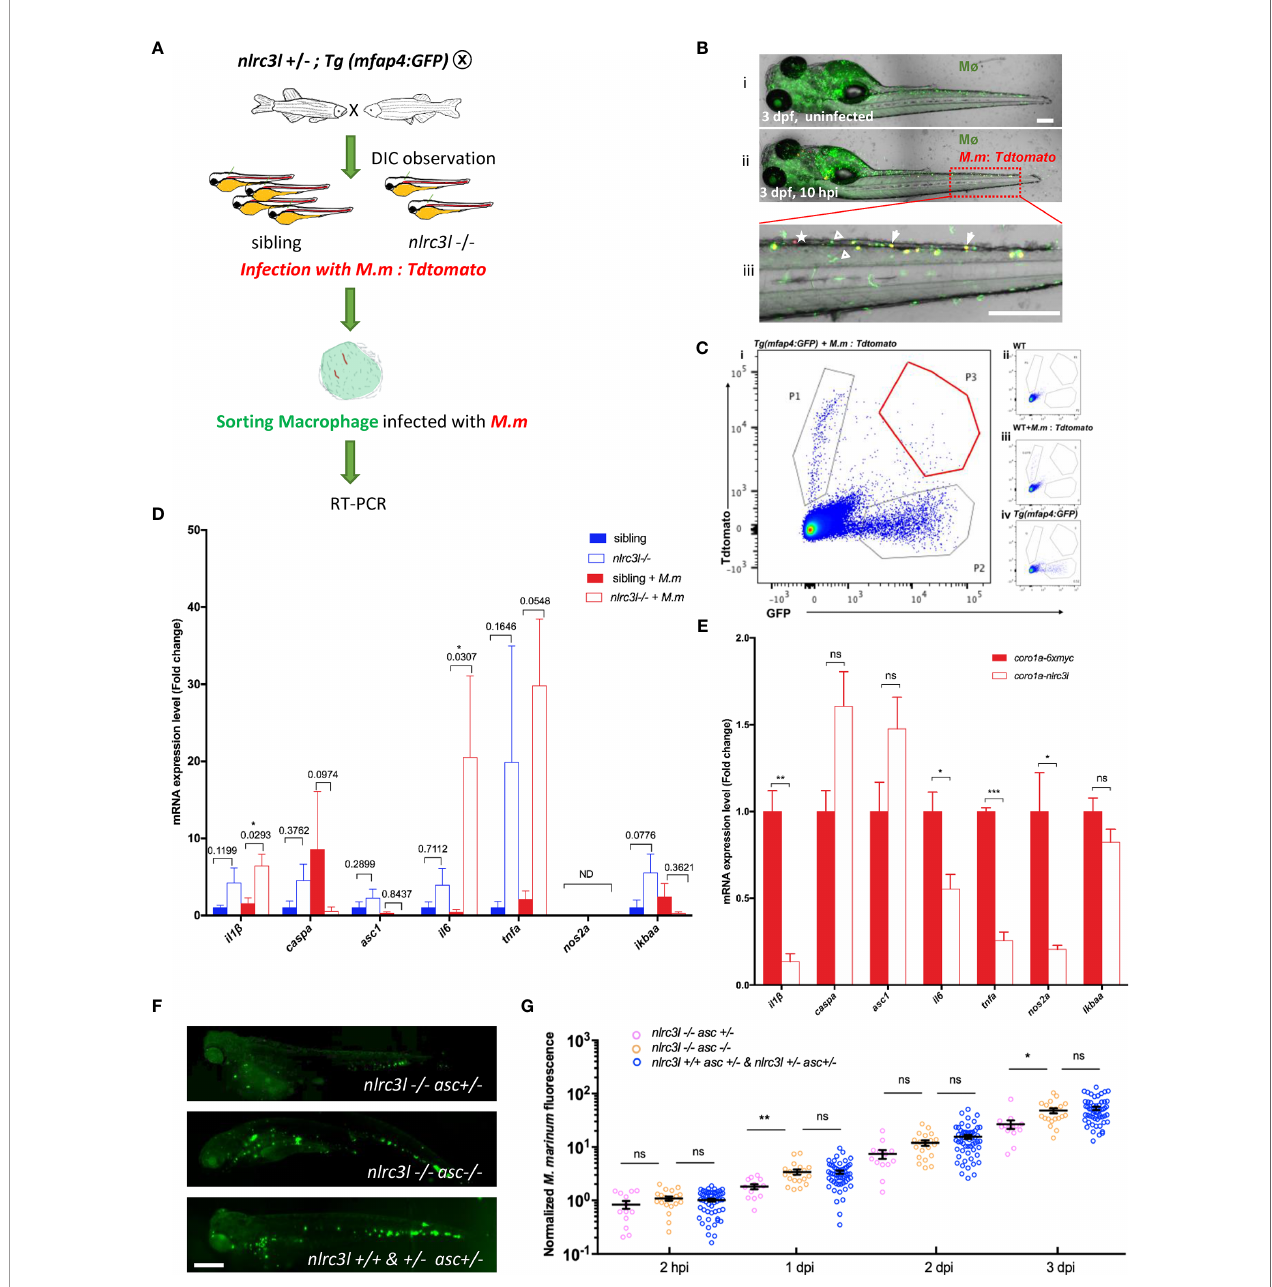
FIGURE 4 | nlrc3-like de fi ciency promotes the activation of macrophage in fl ammasome. (A) Schematic view of FACS of mfap4-GFP + macrophages with phagocytosed Tdtomato + M. marinum and subsequent detection of the expression of in fl ammation-related genes by RT-PCR. (B) A representative image of zebra fi sh embryos infected with M. marinum:Tdtomato at 10 hpi. i uninfected Tg (mfap4-GFP) embryo; ii. Tg (mfap4-GFP) embryo infected with M. marinum: Tdtomato ; iii. Enlarged view of caudal hematopoietic tissue (CHT) region in ii. white arrows indicate macrophages with phagocytosed bacteria; white triangles indicate macrophages without phagocytosed bacteria; white asterisks, free M. marinum . (C) Gating strategy for FACS. i: Sample: Tg(mfap4: GFP) embryos infected with M. marinum:Tdtomato ; ii. uninfected wild-type zebra fi sh; iii. Tdtomato single color control, wild-type zebra fi sh infected with M. marinum:Tdtomato; iv. GFP single color control, uninfected Tg(mfap4: GFP) . P1, free M. marinum:Tdtomato ; P2, mfap4-GFP+ macrophages; P3, mfap4-GFP+ macrophages with phagocytosed M. marinum:Tdtomato . (D) Expression of pro-in fl ammatory genes in macrophages at 10 hpi. The values represent the average of three independent biological repeats, 25 embryos per group in each repeat. (E) The expression of pro-in fl ammatory genes in embryos with overexpressing nlrc3-like in myeloid cells. (F) Representative images of M. marinum:wasabi proliferation in nlrc3-like -/-, asc -/- nlrc3-like -/- , and their nonmutant siblings. (G) Graph of green fl uorescence intensity in nlrc3-like -/- , asc -/- nlrc3-like -/- , and their nonmutant siblings at the indicated time points. The values shown are the combined results of two independent experimental replicates. (B, F) scale bar = 200 m m *p ≤ 0.05; **p ≤ 0.01; ***p ≤ 0.001; ns, not statistically signi fi cant